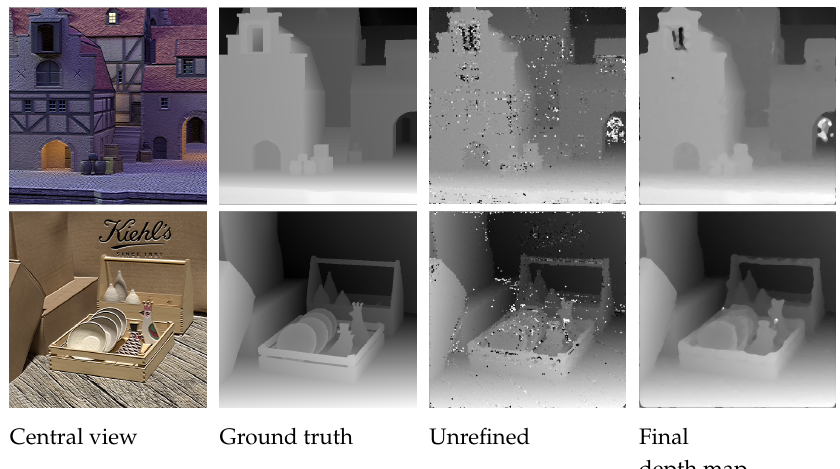
Figure 12. Comparison between the ground truth and the estimated depth map before and after the refinement step for synthetic images.